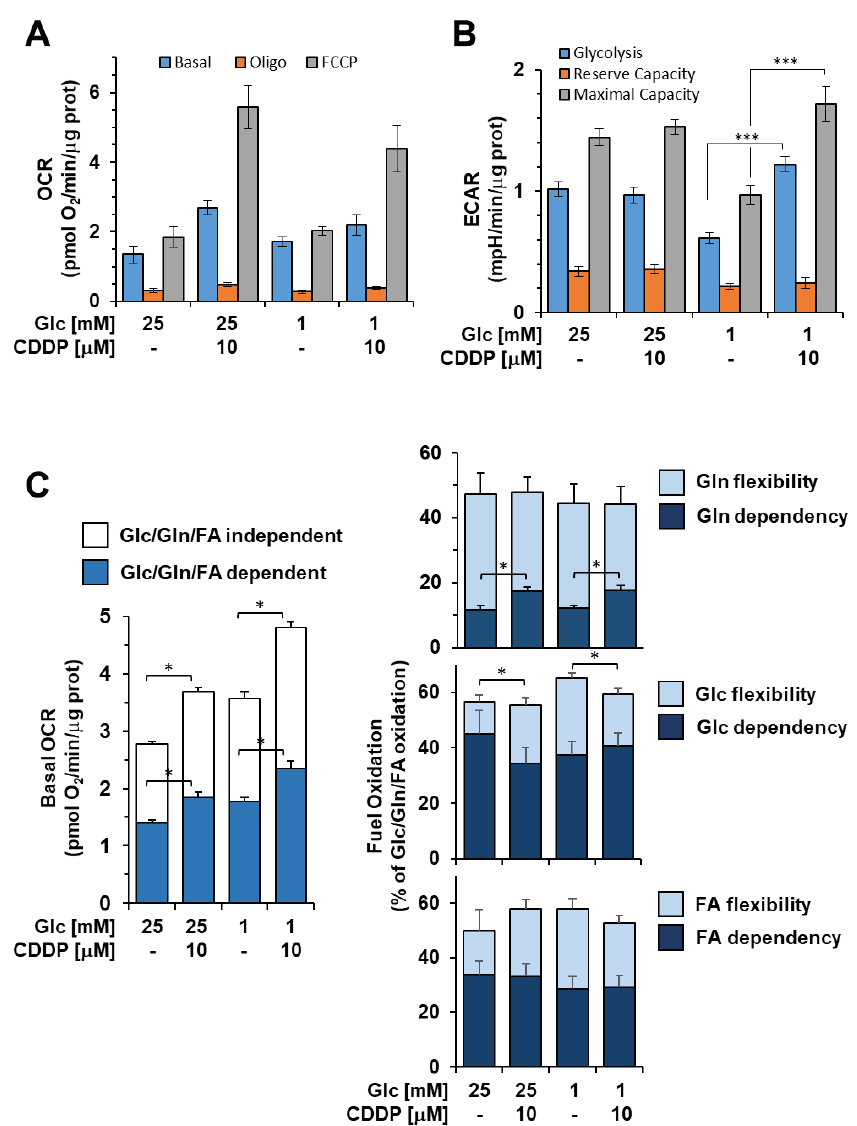
Figure 8. Cisplatin (CDDP) effects on metabolic fluxes and mitochondrial respiratory activities 3AB-OS CSCs. Cells were incubated 48 h with 10 µ M CDDP under high and low glucose growth conditions as indicated and subjected to Seahorse analysis for OCR ( A ) and ECAR ( B ) as detailed in Figure 1A,B. Bar values are means ± SEM of three independent biological replicates each carried out in triplicate; ***, p < 0.001. ( C ) Mitochondrial dependency on and flexibility for oxidation of glucose (Glc), glutamine (Gln), and long chain fatty acids (FA) in presence or absence of CDDP, in high and low glucose nutrient media. The bar histogram on the left shows the combined contribution of glucose (Glc), glutamine (Gln) and long chain fatty acids (FA) to the basal OCR; the residual activity is defined as Glc/Gln/FA-independent OCR. The tripartite bar histograms on the right show the dependency and flexibility of the 3AB-OS OCR relatively to one or the other of Glc, Gln and FA as respiratory substrates. Bar values are means ± SEM of three independent biological replicates each carried out in triplicate; *, p < 0.005. See Materials and Methods for further details. Abbreviations: oligo , oligomycin; FCCP , carbonyl cyanide 4-(trifluoromethoxy)phenylhydrazone; OCR , oxygen consumption rate; ECAR , extracellular acidification